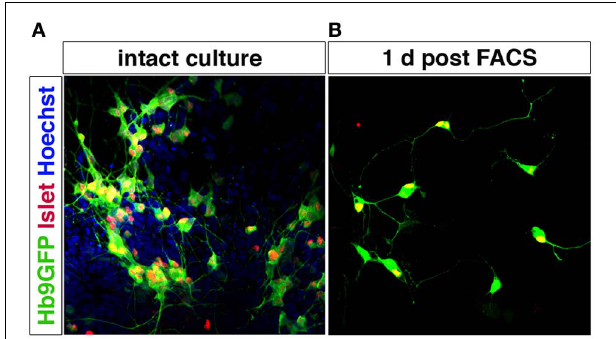
FIGURE 6 | Motor neurons can be purified by FACS using Hb9-GFP expression. Spinal motor neurons derived from Hb9-GFP mESCs extend processes and express Islet-1/2. Hoechst staining of all nuclei shows that the intact culture contains cells other than motor neurons ( A ). Hb9-GFP motor neurons enriched by FACS show a healthy appearance with extended processes 1 day post sorting ( B